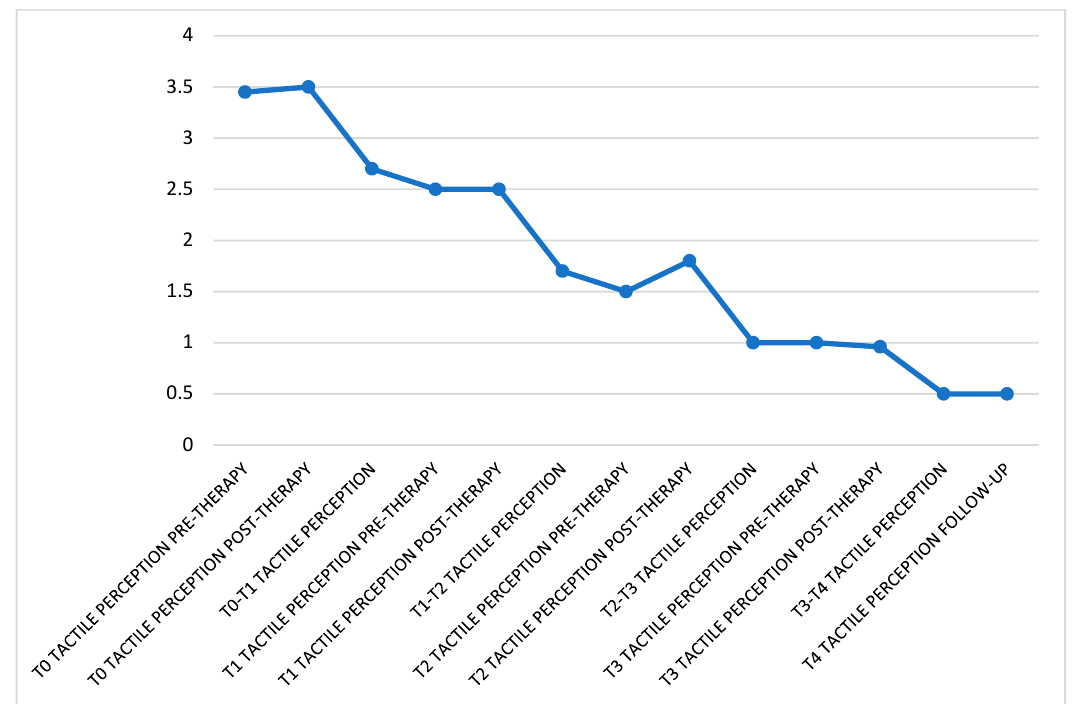
Figure 4. In this graph can be seen the trend of tactile perception perceived throughout the treatment. The data were divided as follow: perception felt before the patient was subjected to treatment, right after the irradiation of the lesion and in the days following the session. The data refer to the entire month of observation.